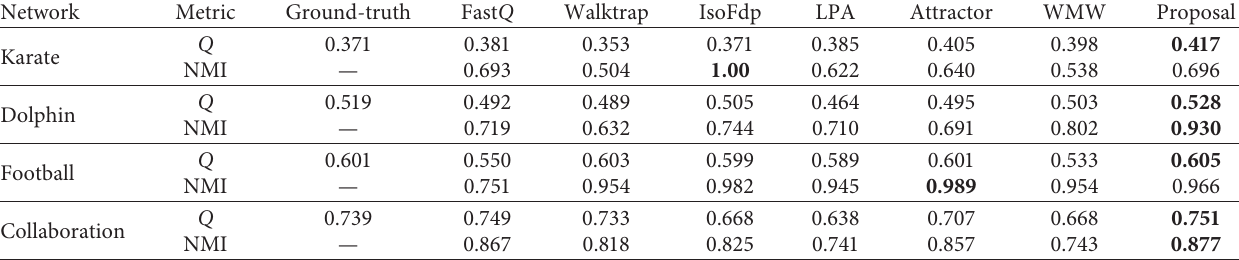
Figure 1: Comparison of results detected by the proposed method and comparison algorithms. (a) The results detected from the networks containing 1000 vertices. (b) The results extracted from the networks containing 5000 vertices. (c) The results discovered from the networks containing 10000 vertices. Table 3: The modularity and the NMI detected from networks with ground-truth community structure by the comparison algorithms and the proposed